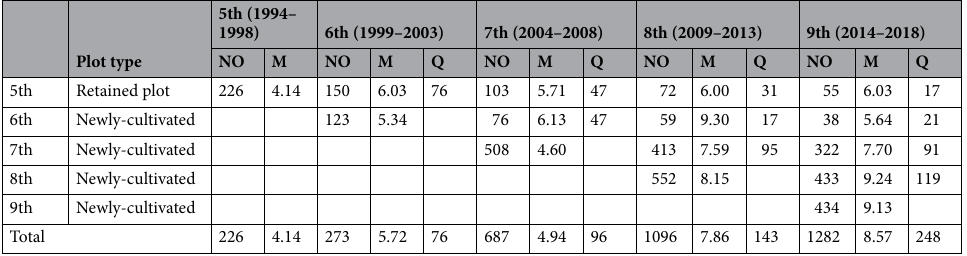
Table 3. Quantity of newly-cultivated, retained, and abandoned sample plots during different NFIs. “Q.” refer to abandoned sample plots.